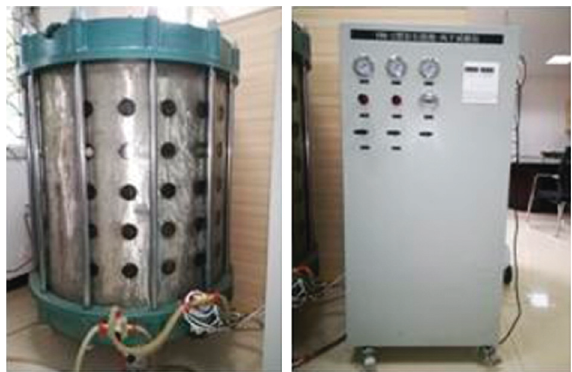
Figure 3: YRK-2 rock immersion-air drying test